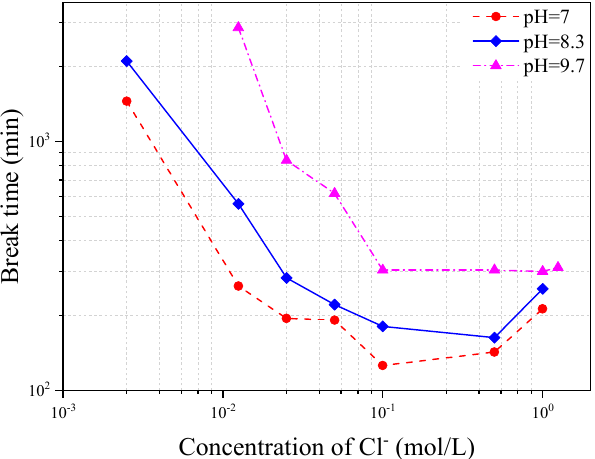
Figure 16. Variation of steel wire break time with chloride concentration in three different types of simulated concrete pore solutions.